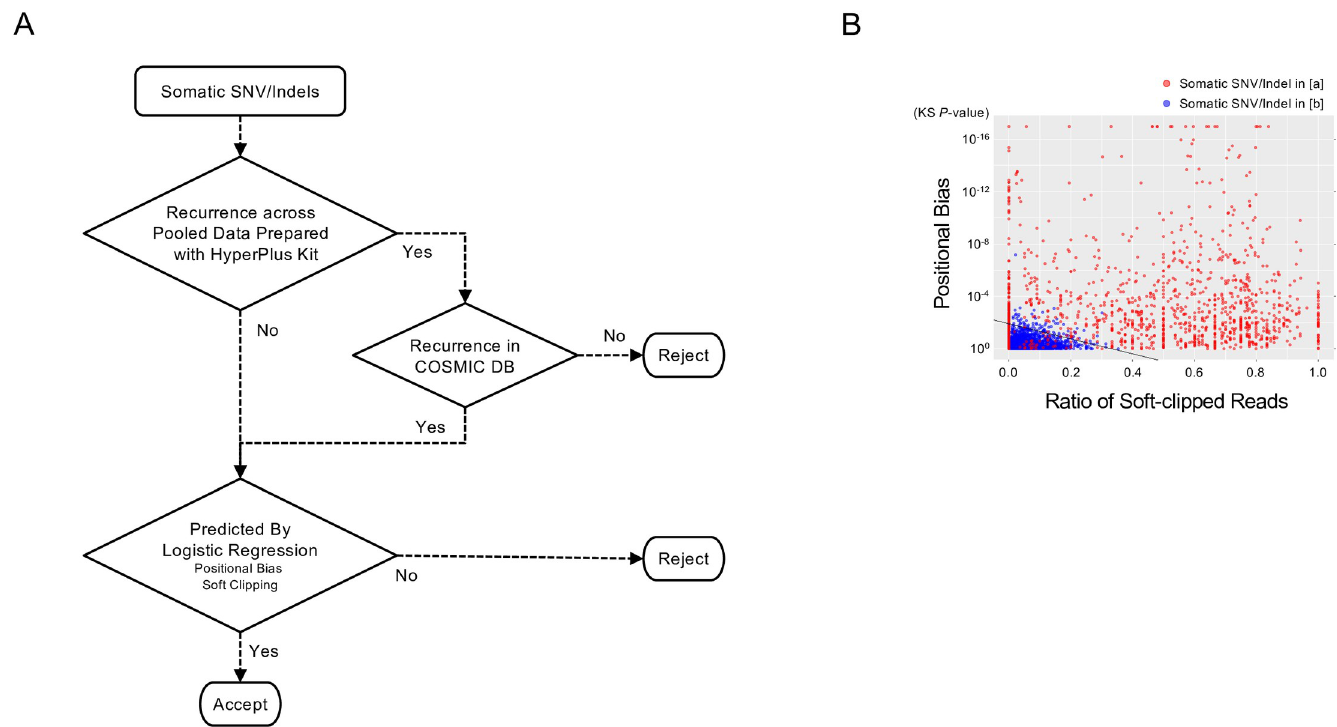
Fig 4. Filtering process for the removal of somatic SNV/indel noise generated by treatment with the HyperPlus kit. (A) Algorithm for the filtration of somatic SNV/indel noise in libraries prepared with the HyperPlus kit. (B) Relationship between soft clipping of a read and an SNV/indel position in the read. 2-D scatter plots present the relation between the ratio of soft-clipped reads and the p -value, as determined using the Kolmogorov-Smirnov (KS) test for positional bias of the SNV/indel in the read. Circles denote SNVs/indels detected using the HyperPlus kit only (red; category [a] in Fig 3A) and SNVs/indels detected using both the HyperPlus and SureSelect kits (blue; category [b] in Fig 3A). The black line indicates the threshold by logistic regression to distinguish SNVs/indels in category [a] from those in category [b] according to the generalized linear